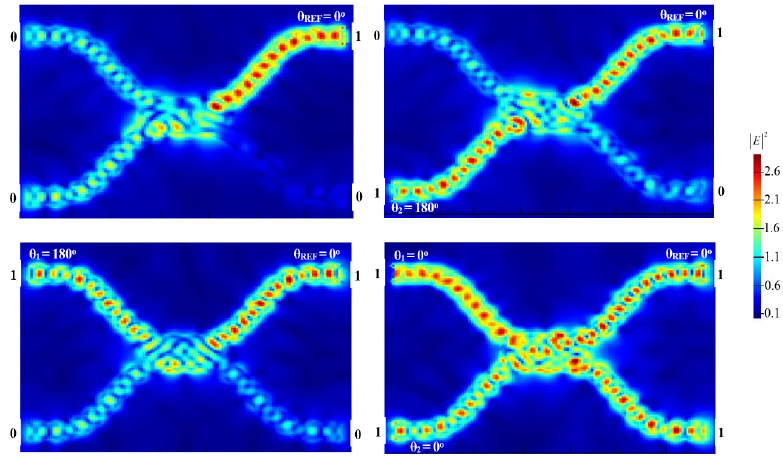
Figure 9. Light field distributions for AND function utilizing 2 × 2 silicon waveguide at 1.55 μ m.